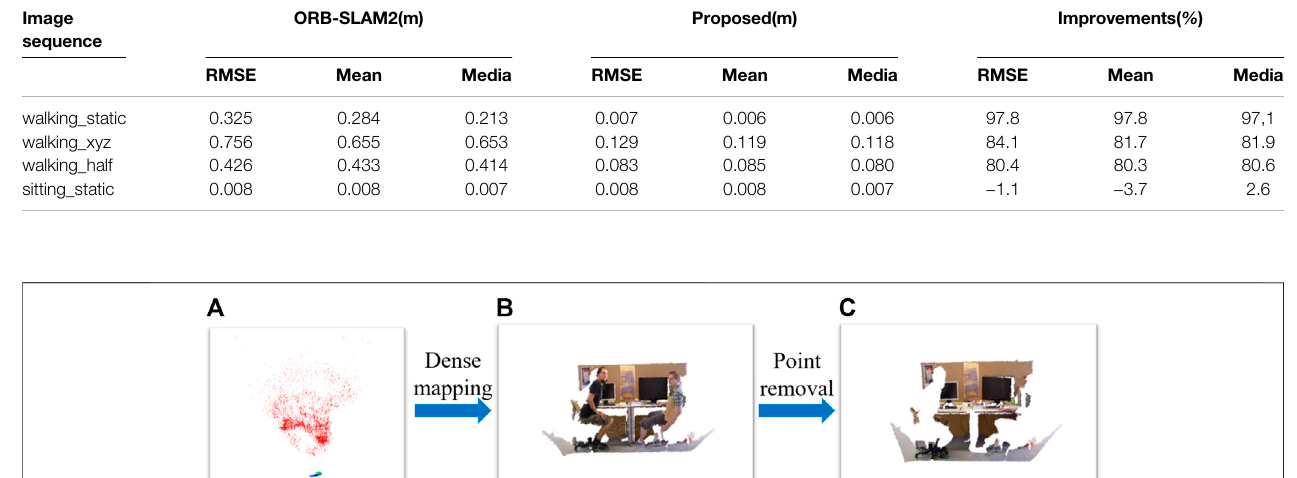
TABLE 1 | The comparison of absolute trajectory error of pose estimation in TUM dataset. Image sequence